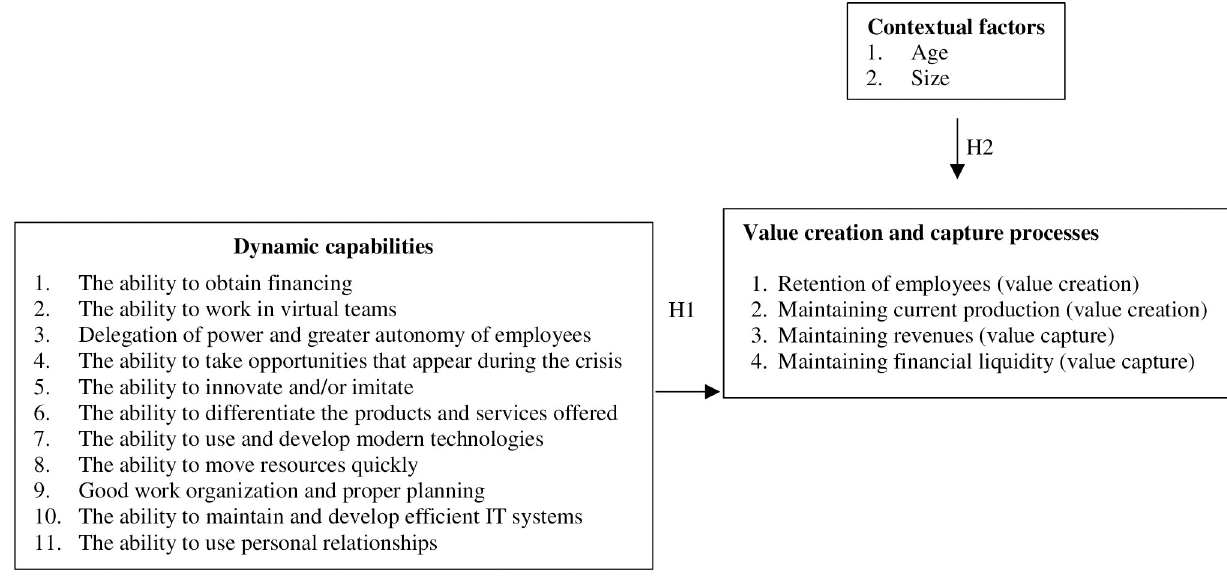
Fig 1. Dynamic capabilities influencing the value creation and capture processes.